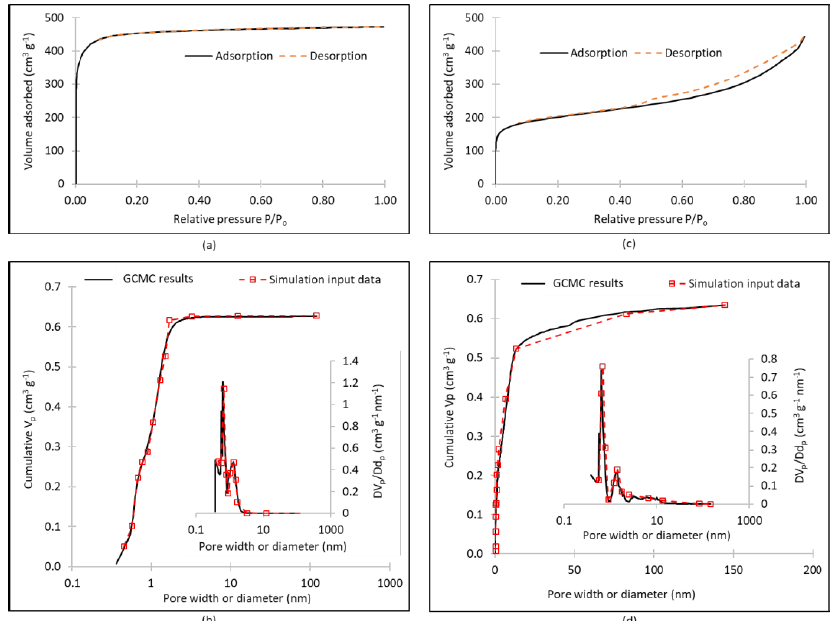
Figure 3. Nitrogen adsorption/desorption experimental data and analysis results: adsorption/desorption isotherms for ( a ) the ACF fabric and ( c ) the AC coating; pore size distribution (PSD), derived from the experimental adsorption isotherms using the GCMC method, of ( b ) the ACF fabric and ( d ) the AC coating from experimental data and fitted discrete PSD lines used as input data in the simulations in this paper.